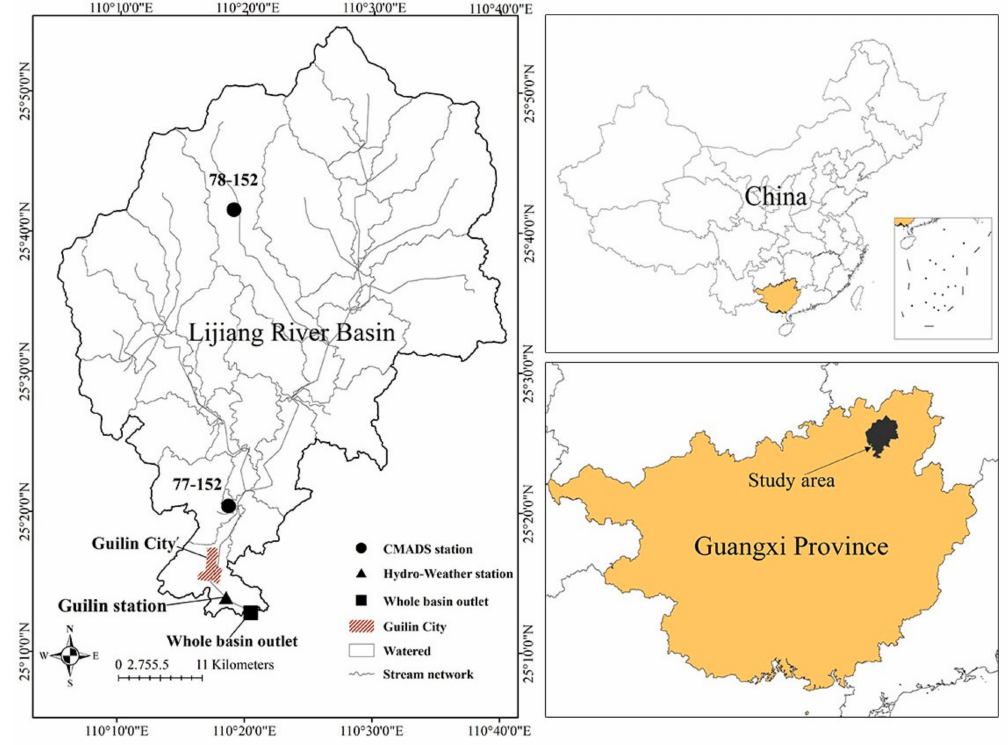
Figure 1. The location of the study area in China.